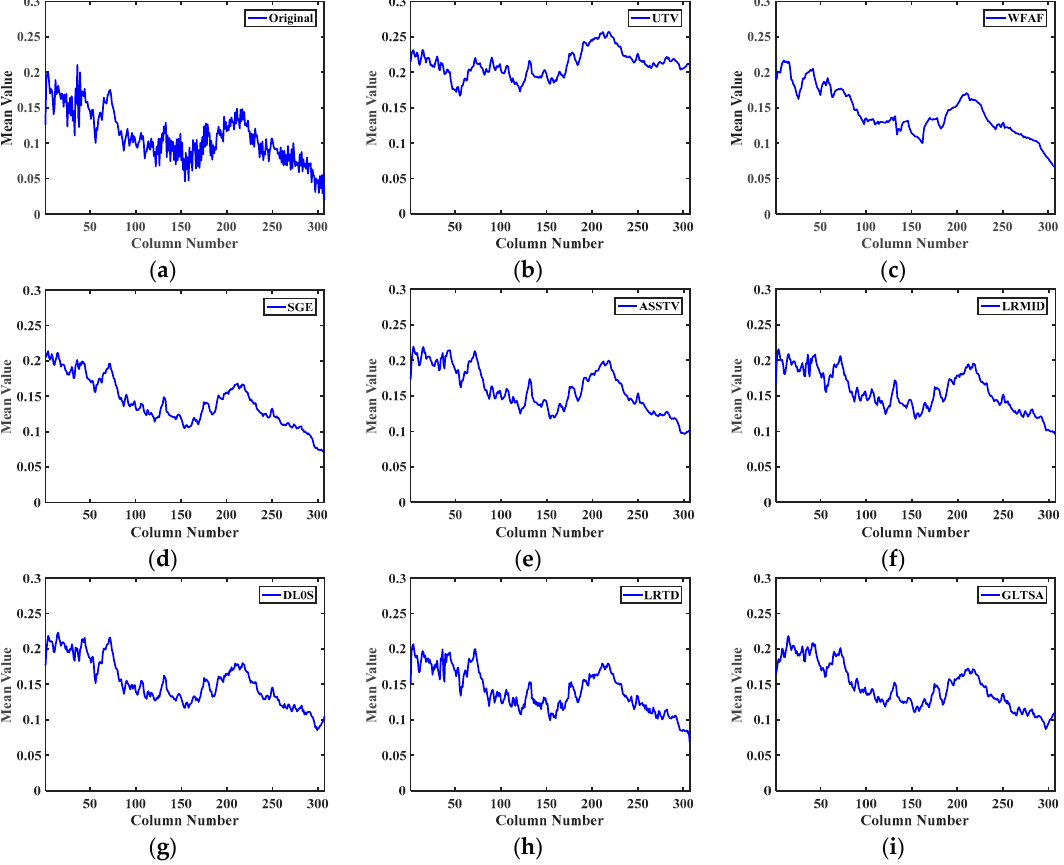
Figure 11. Spatial mean cross-track profiles for the first real data: ( a ) original real image; and destriping results by ( b ) UTV, ( c ) WFAF, ( d ) SGE, ( e ) ASSTV, ( f ) LRMID, ( g ) DL0S, ( h ) LRTD, and ( i ) GLTSA.